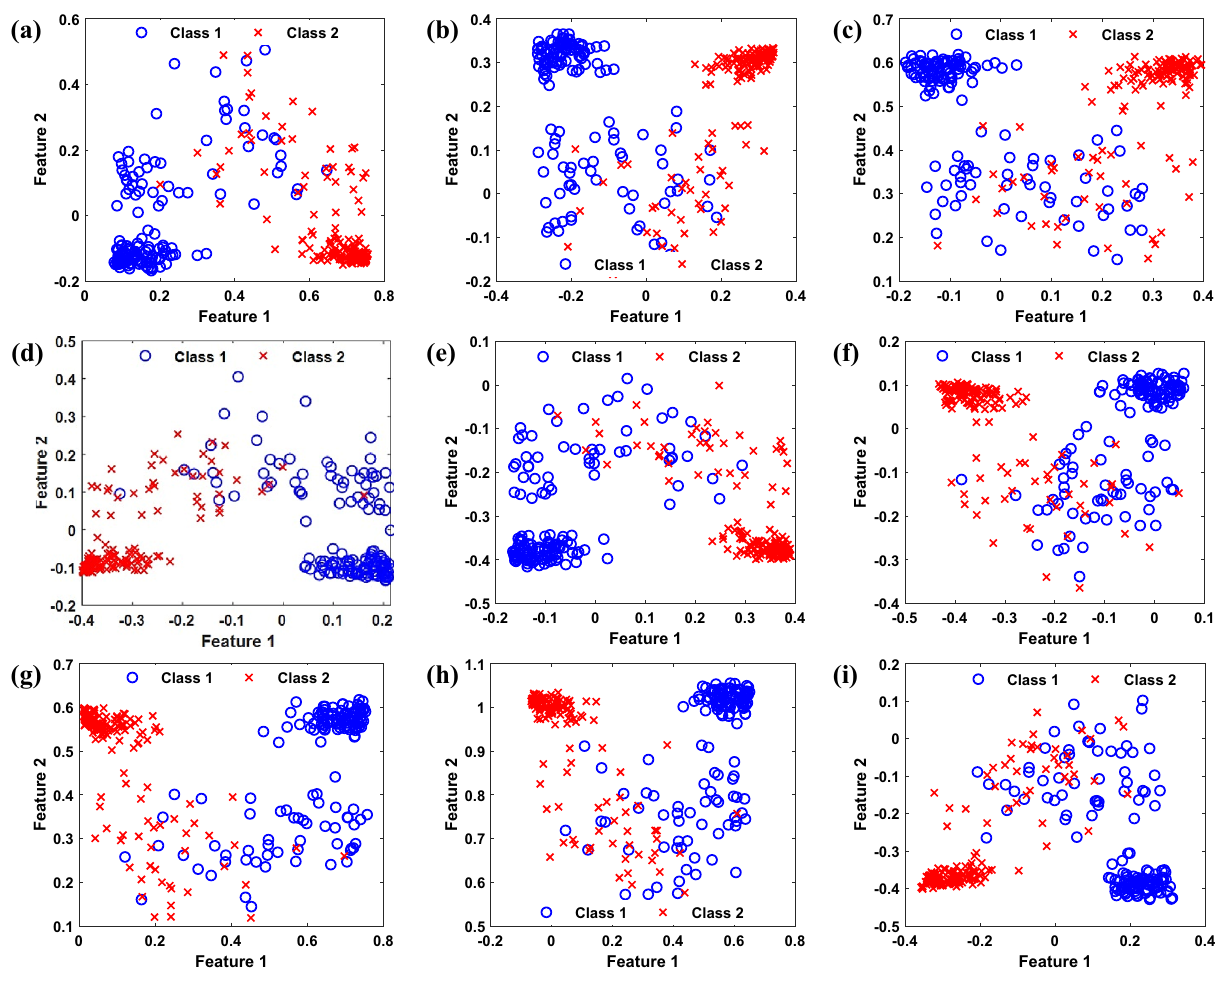
Figure 10. Features obtained from SDA considering the different length and location for the sliding window. ( a ) second window of length two seconds, ( b ) seventh window of length two seconds, ( c ) 12th window of length two seconds ( d ) second window of length three seconds, ( e ) seventh window of length 3 s, ( f ) 12th window of length three seconds ( g ) second window of length three seconds, ( h ) sixth window of length three seconds, and ( i ) ninth window of length three seconds.